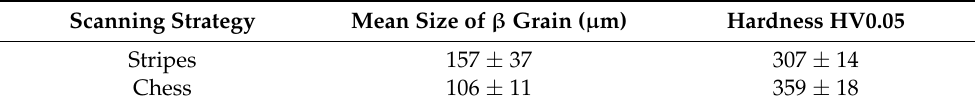
Table 3. Mean grain size and micro-hardness of the LPBFed Ti6Al4V samples. Figure 2. LPBFed Ti6Al4V microstructure at different magnifications (BD stands for building direction).